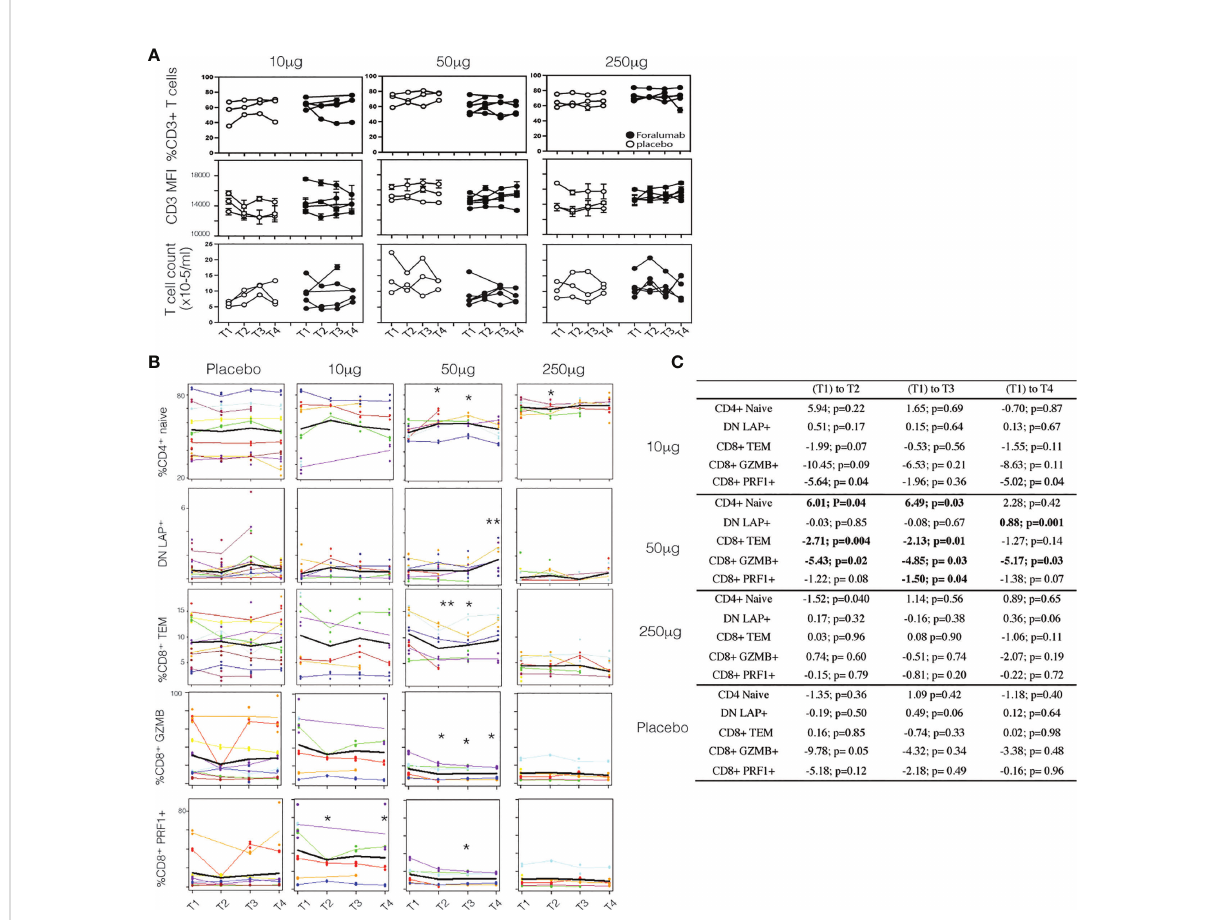
FIGURE 2 Surface CD3 and Foralumab dosing (A) Longitudinal PBMCs were stained for CD3 and measured for changes in frequency of CD3+ cells, the intensity of CD3 (MFI) and total T cell counts as compared to baseline (T1) levels. (B) Lineage and differentiation markers in 10ug, 50ug, 250ug and placebo groups. CD4+CD45RA+CD27+ are CD4+ naïve; CD3+CD4-CD8- are DN LAP+; CD8+CD45RA-CD27- CD8 Tem; GZMB+ and PRF1+ in total CD8+ cells is shown. (C) Shows the change with time was estimated using a linear mixed effects model with a fi xed categorical effect of time and a random intercept. *p<0.05, **p<0.001). N=6, placebo